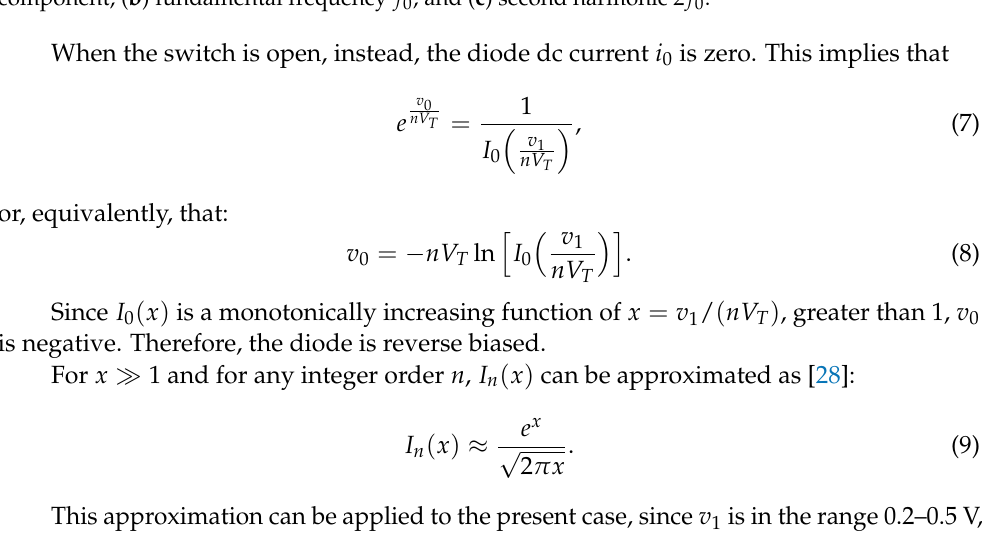
Figure 3. Equivalent circuits for the different signal components flowing through the doubler: ( a ) dc component, ( b ) fundamental frequency f 0 , and ( c ) second harmonic 2 f 0